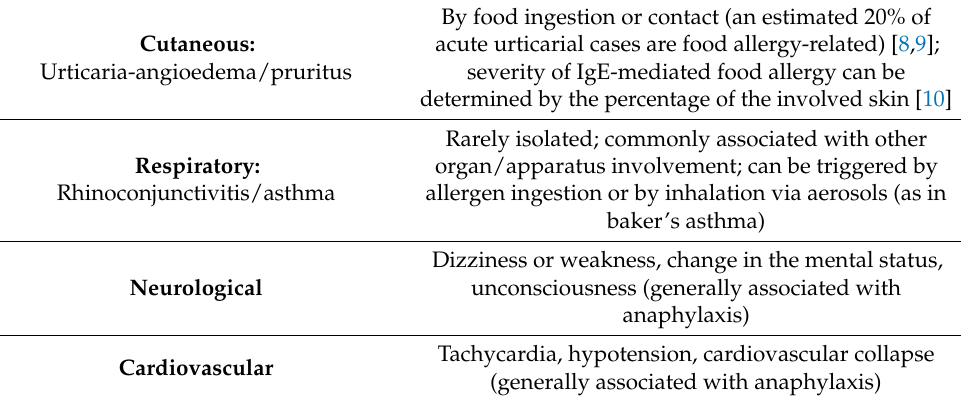
Table 1. Clinical presentations of IgE-mediated food allergy beyond the GI